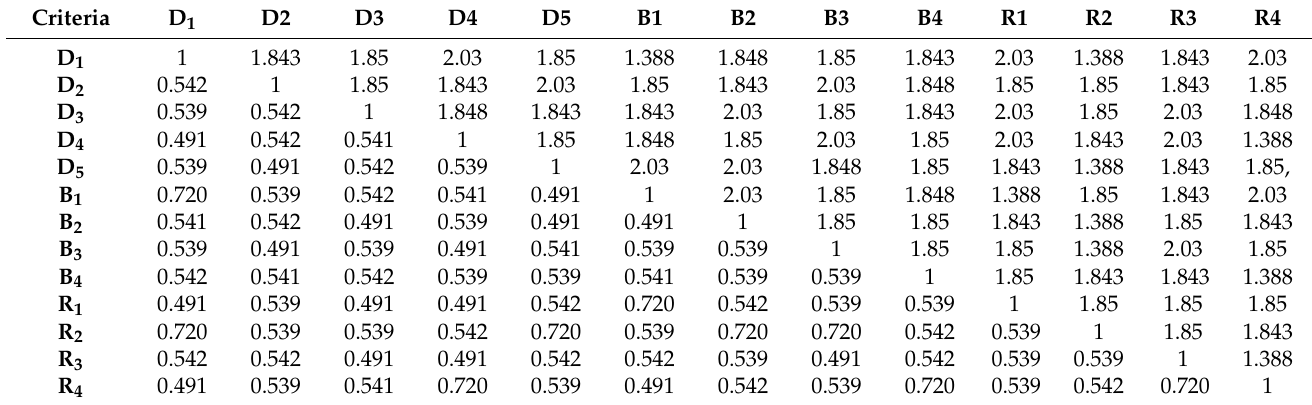
Table 3. The initial aggregated decision-maker judgments for the driver, barrier, and risk